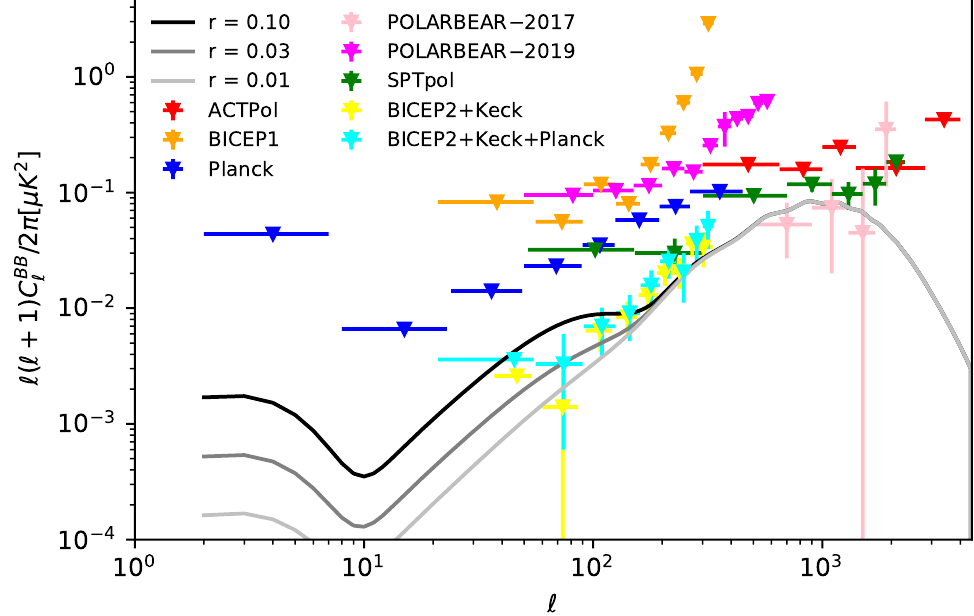
Figure 3. Some observed B-mode powers from CMB experiments. The x -axis is a logarithmic scale of the multipoles l, whereas the y -axis reports the temperature fluctuations of B-modes. The factor l ( l + 1 ) ensures that l ( l + 1 ) C l is constant at low l s for a nearly scale-invariant spectrum of density perturbations. Data with error bars on the y -axis are significant detections, while the remaining are 95% upper limits. Data were taken from the NASA/LAMBDA website. Theoretical curves for r = 0.1 and r = 0.01 are shown respectively with black and grey